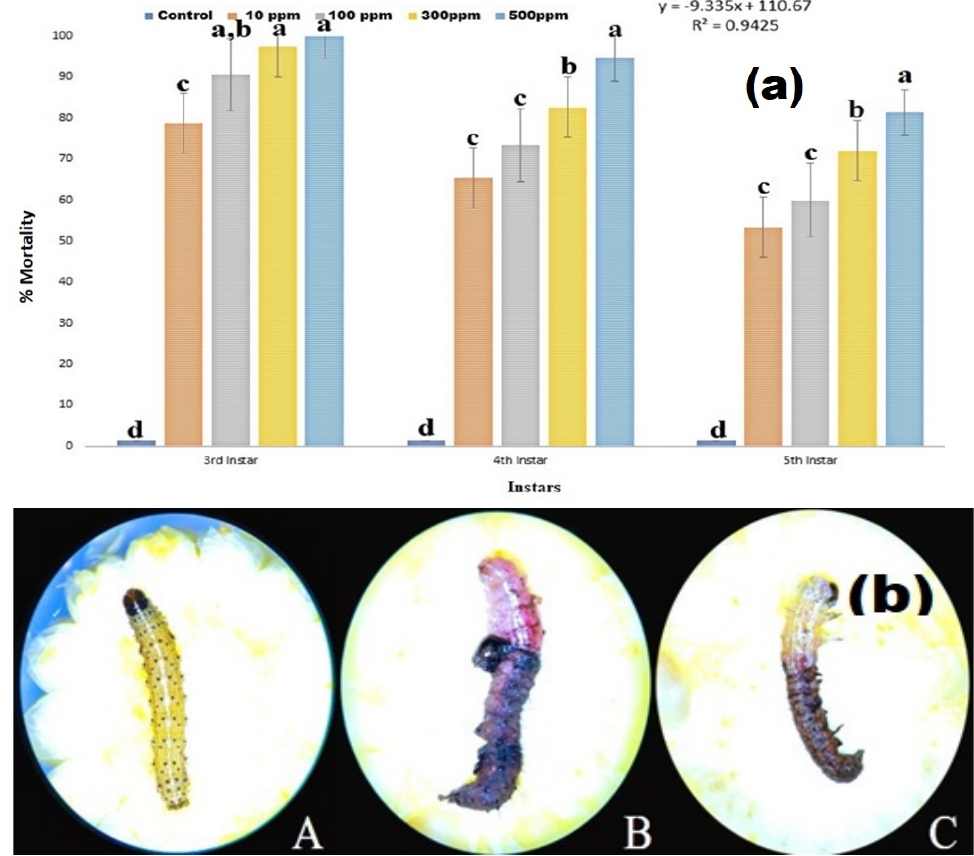
Figure 3 . ( a ) is larvicidal activities of copper nanoparticles against 3rd, 4th and 5th instar larvae. ( b ) is morphological changes of control and nanoparticles treated larvae. (A) . CuO ( b ) is morphological changes of control and nanoparticles treated larvae. ( A ). CuO NPs effects on NPs effects on 3rd, 4th, and 5th instar larvae of S. frugiperda after 24 h of nanoparticles treatment . (B) CuO NPs effects on control and treated S . frugiperda larvae ( A control larvae ( nanoparticles free ) , (B, C ) nanoparticles treated larvae ). According to the Tukey test at p ≤ 0.05, statistical values followed by the same letter do not differ significantly (one ‐ way ANOVA).